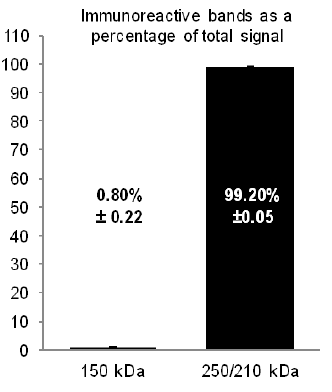
Figure 8. Quantification of α immunoprecipitated from mouse brain extracts (Triton X-100) with FP1 before fractionation by SDS-PAGE and immunoblotting with FP1 and CNC1 antibodies (see Figure 3 and Figure 6). All α immunoreactive bands at the longest film exposure were quantified in Adobe Photoshop, shown here as average percent of total immunoreactivity per blot.